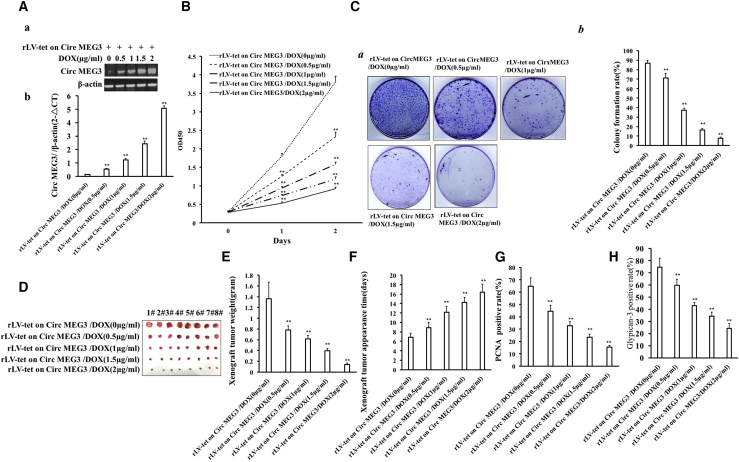
CircMEG3 inhibits the growth of human liver cancer stem cells in vitro and in vivo(A) Back-to-back RT-PCR was used to detect CircMEG3 in the cells at different concentrations of DOX (0, 0.5, 1, 1.5, 2 μg/mL) (E: semiquantitative; F: quantitative). β-Actin serves as an internal reference. (B) Growth curve assay using CCK8. (C) The crystal violet staining method was used to determine the plate colony-forming ability. (Ca) Photograph of cell colonies. (Cb) The analysis of colony formation rate. (D) Photos of transplanted tumors (xenograft). (E) Comparison of the size (g) of transplanted tumors. (F) Comparison of the appearance time (days) of transplanted tumors. ∗∗p < 0.01 or ∗p < 0.05 means statistical difference is significant. (G) 4% formaldehyde-fixed, paraffin-embedded transplanted tumor tissue sections (4 μm) were subjected to anti-PCNA immunohistochemical staining. The comparison of PCNA-positive rates of transplanted tumors. (H) The comparison of Glypican-3-positive rates of transplanted tumors.